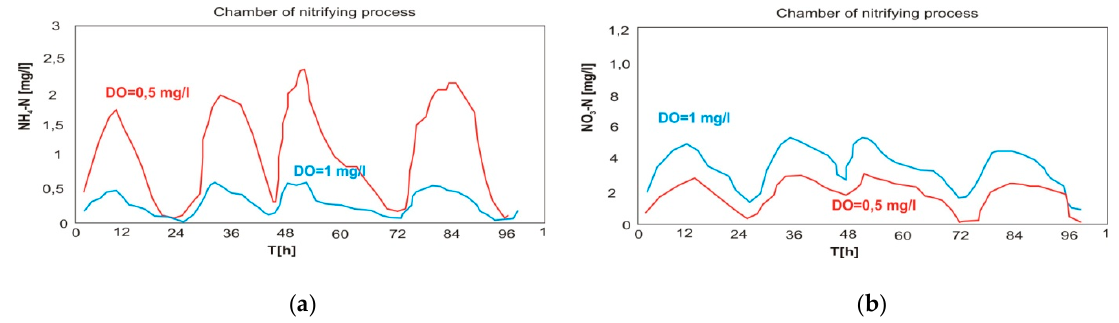
Figure 11. Changes in the concentration of ammonium nitrogen ( a ) and nitrate nitrogen ( b ) in the both nitrifying chambers at different concentrations of dissolved oxygen [own elaboration].